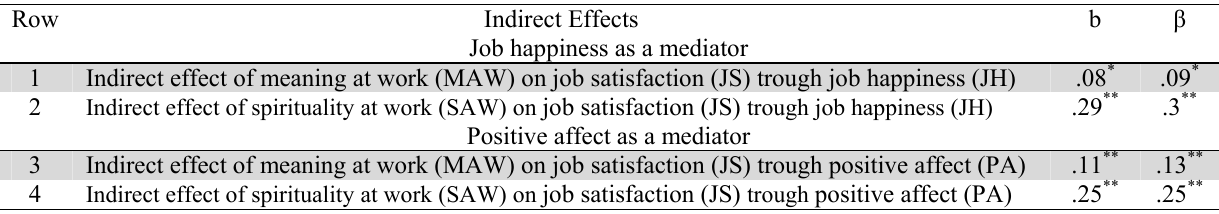
Standardized and unstandardized indirect effects in final and revised models of research Row Indirect Effects b β